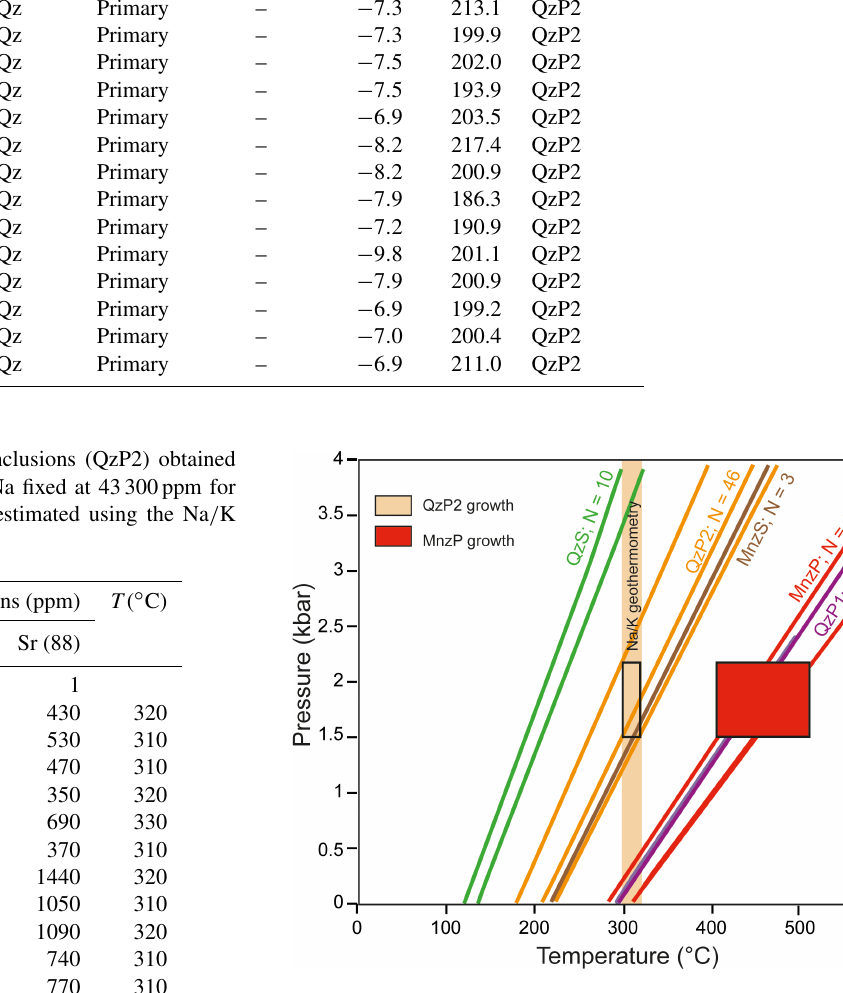
Figure 6. Geothermobarometric results obtained for fluid inclusions of the Alpine cleft. Mean isochoric P – T relationships calculated from microthermometric measurements of fluid inclusions in mon- azite and quartz showing three main stages of growth. Fluid inclu- sion populations and number of analyses are indicated. P – T esti- mation for the main episode of quartz growth (QzP2) is obtained by the intersection of the T interval determined by the Na / K geother- mometer (300–320 ◦ C) with the QzP2 isochore. It gives a pressure estimates of 1.5–2.2kbar for the main phase of quartz growth, that was used to determine the maximal T range (410–520 ◦ C) for mon- azite (MnzP)